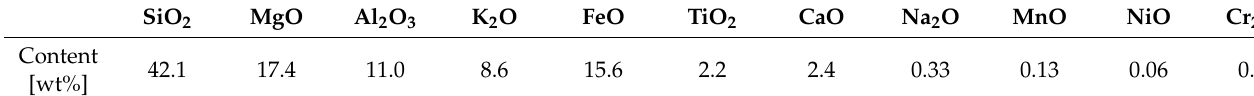
Figure 4. SEM images of Palabora vermiculite expanded by ( a ) H 2 O 2 treatment followed by micro- wave drying, and ( b ) thermal treatment at 1000 °C. The white scale bars correspond to 500 µm.